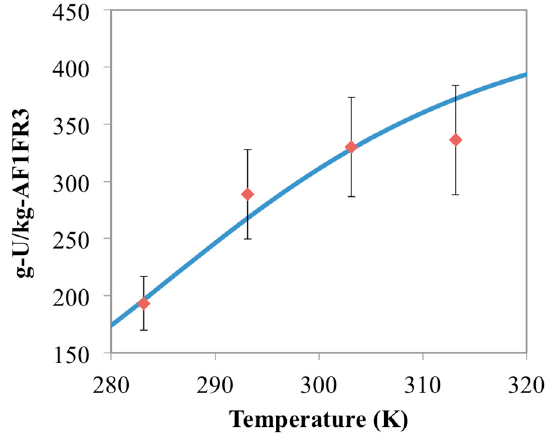
Figure 5. Comparison between chemisorption model results (blue line) and the AF1FR3 experimental data (red diamonds) for 5 mg of material. Error bars represent two standard deviations of the data.